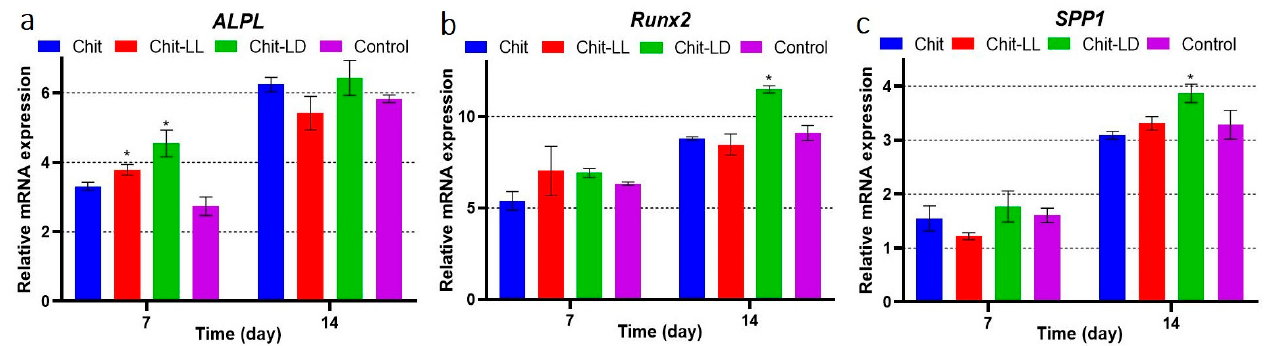
Figure 10. Differential expression of genes involved in osteodifferentiation. MSCs were cultured on the chitosan (Chit), chitosan-g-oligo(L,L-lactide) (Chit-LL), and chitosan-g-oligo(L,D-lactide) (Chit- LD) films. Monolayer cell culture was taken as a control. MSCs were cultured in osteogenic medium (OS) for 14 days. The data of the qRT-PCR analysis of bone specific markers ALPL , Runx2 , and SPP1 . The data are presented as fold changes of transcription levels of osteo-induced MSCs vs. MSCs. Data are expressed as the mean ± SD. All experiments were performed in triplicate.